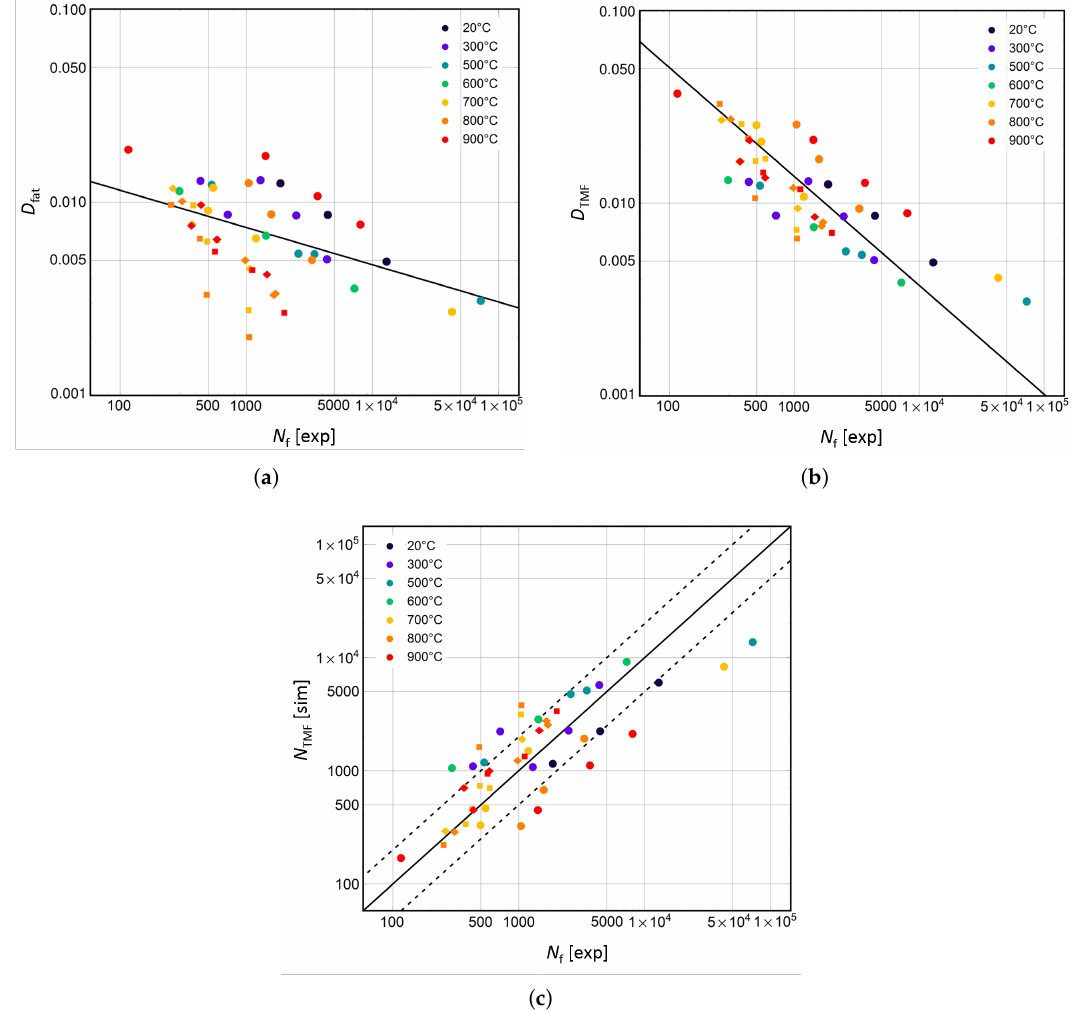
Figure 3. Predictions of the microcracks growth lifetime models for the Ni-Resist D-5S alloy. ( a ) Instantaneous damage parameter (34)–(36), ( b ) accounting for creep (47)–(49) and ( c ) the respective number of cycles to failure (46) for LCF and TMF tests at various conditions. The filled circles ( u ) represent LCF tests, the squares ( p ) represent non-isothermal IP tests and the diamonds ( f ) show non-isothermal OP tests. The highest temperature of the TMF tests is indicated by the color whereas the lowest temperature of 400 ◦ C was the same for all TMF